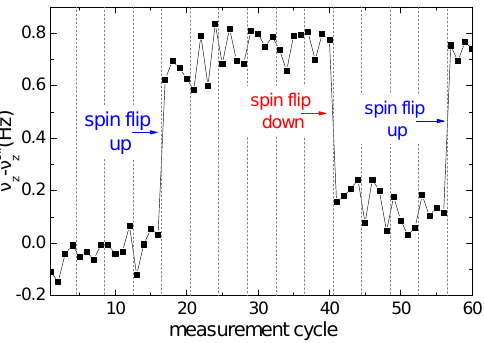
Figure 3. Detection of three induced spin flips of a single 12 C 5 + ion by a change of the ion’s axial oscillation frequency. The frequency change amounts to 0.58Hz in a total frequency of 411kHz. Every four axial frequency measurement cycle microwaves around the Larmor frequency are